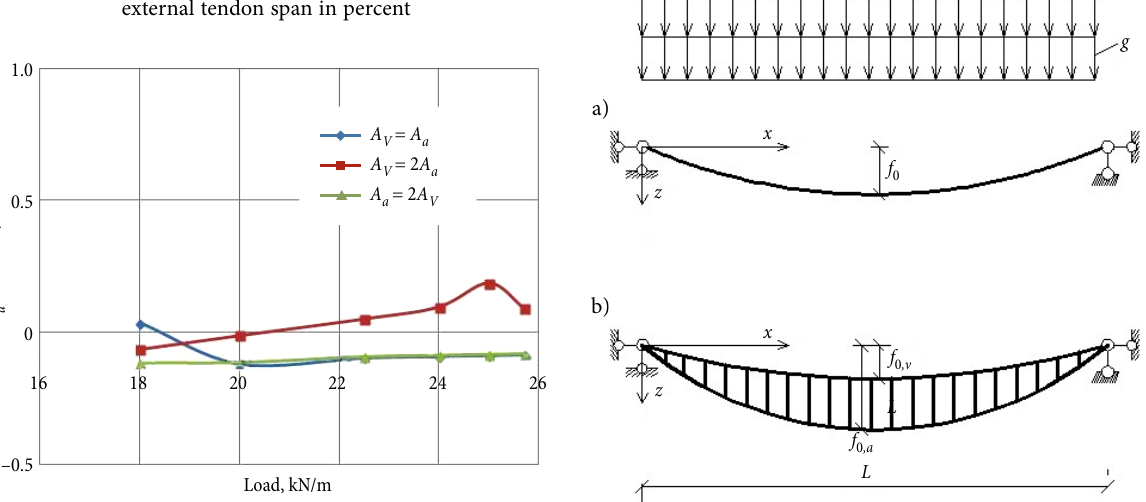
Fig. 5. The difference between thrust force calculations of the lower cable in the middle of the stress-ribbon structure with external tendon span in percent